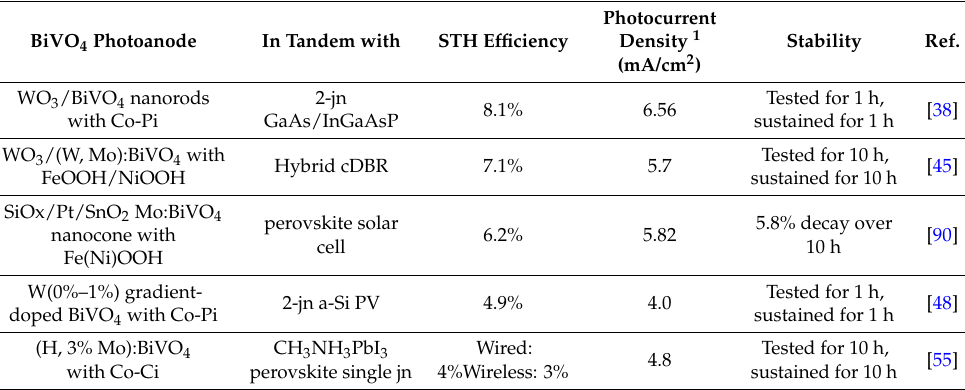
Table 2. BiVO 4 photoanode-based PEC–PV/perovskite Tandem Devices.